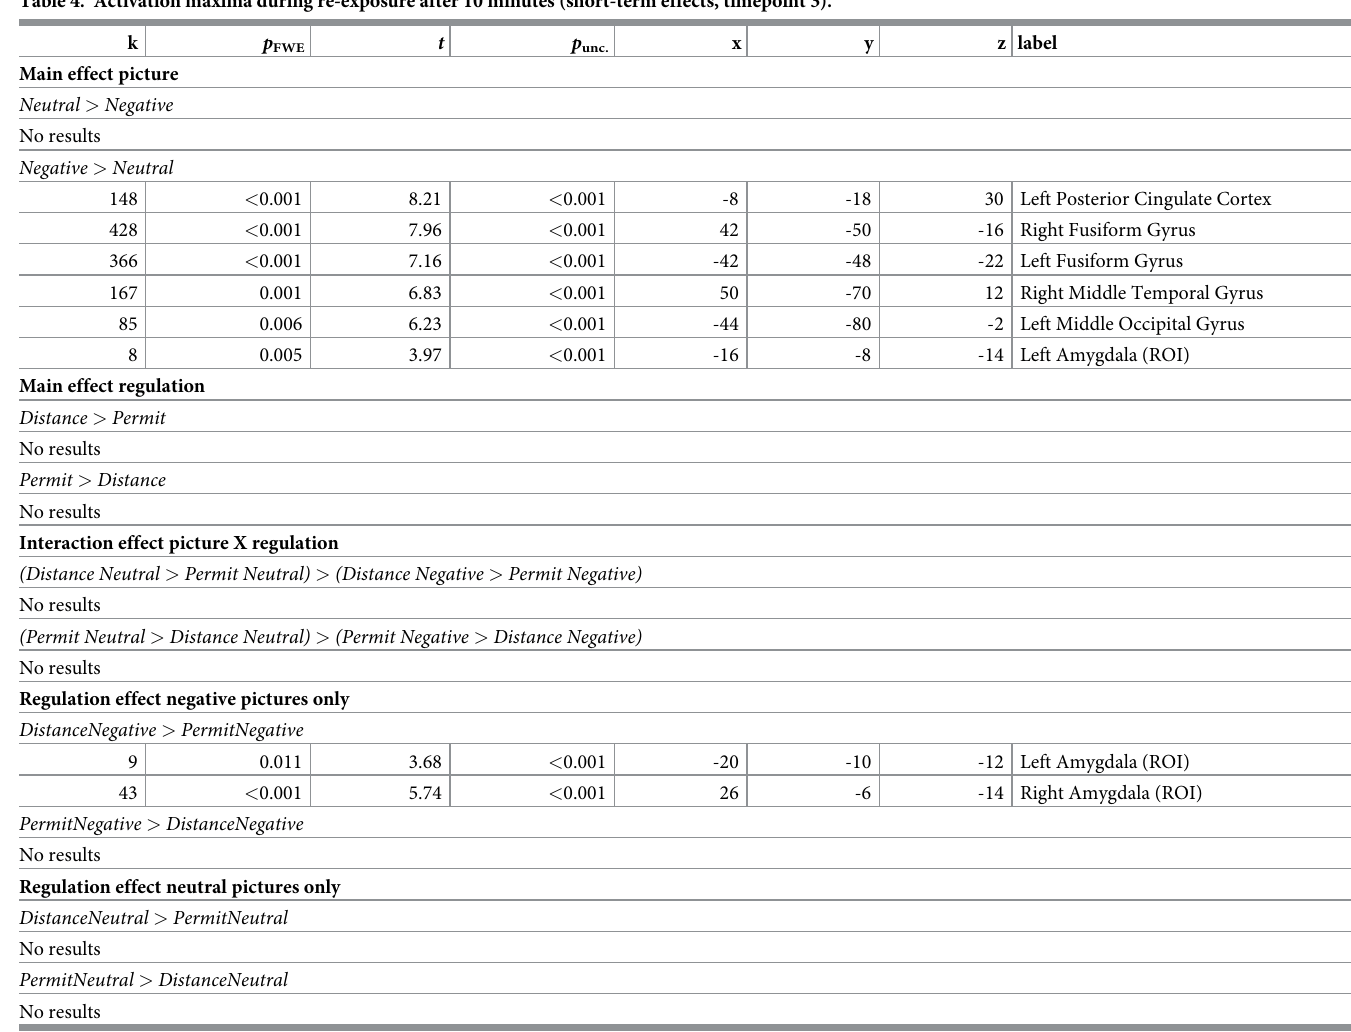
Table 4. Activation maxima during re-exposure after 10 minutes (short-term effects, timepoint